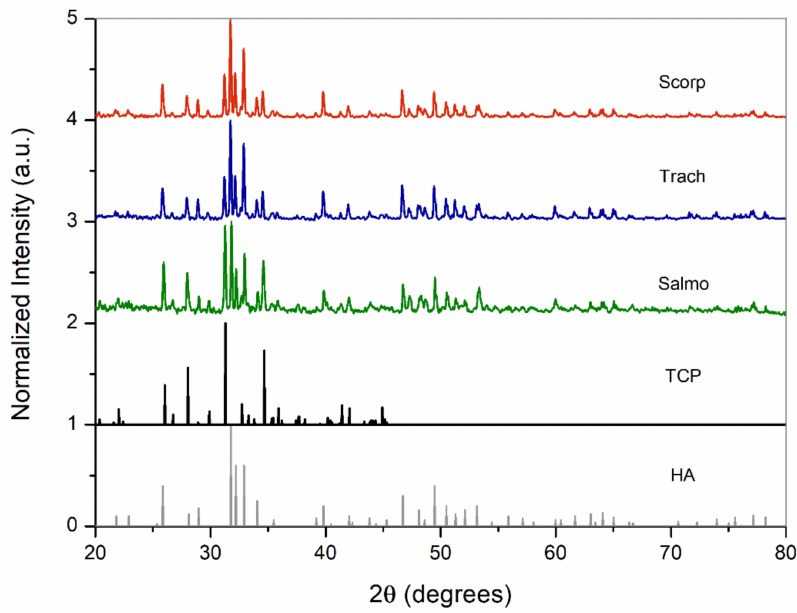
Figure 7. XRD patterns of material thermally treated at 950 ◦ C compared with stoichiometric HA and